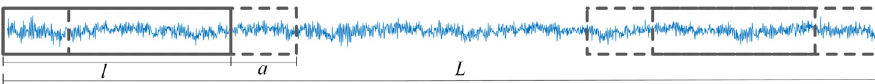
Figure 5. Decay of the learning rate in model training.